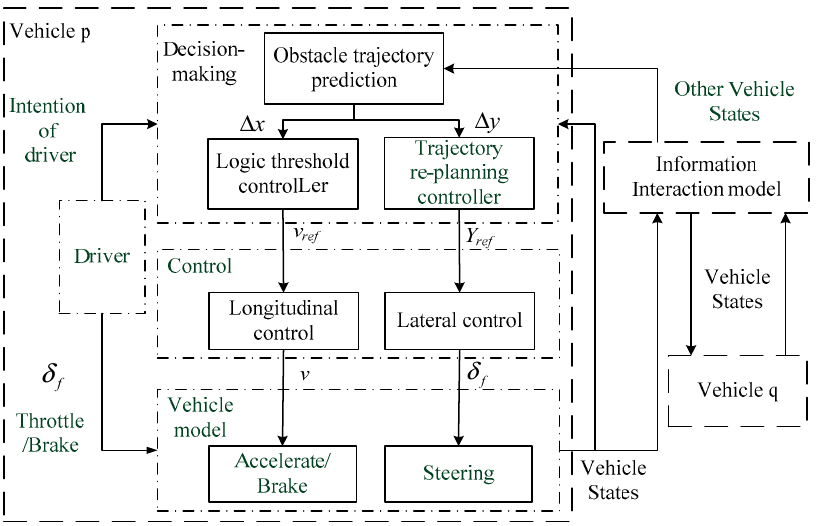
Figure 7. Lane-exchanging vehicle trajectory re-planning control framework.